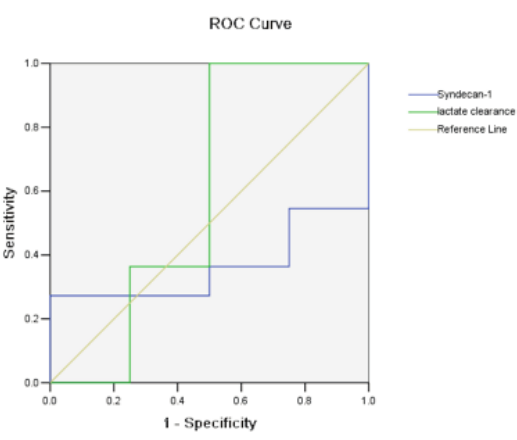
Figure 1: Comparison of diagnostic value of plasma syndecan-1 concentrations and lactate